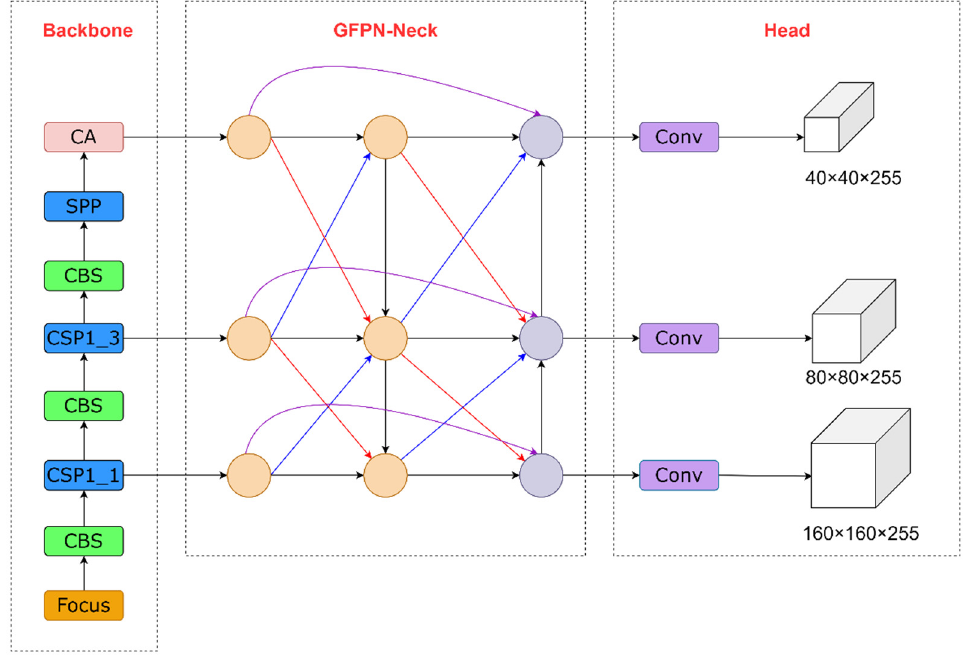
Figure 9. The improved network structure for RD-YOLO. The 32× downsampling feature fusion layer is removed. The 4× downsampling feature fusion layer is added. The CA attention mechanism is inserted behind the Backbone. The PANet is replaced by GFPN to fuse the multiscale features. The CIOU Loss function is replaced by Focal-EIOU Loss to enhance the regression efficiency.